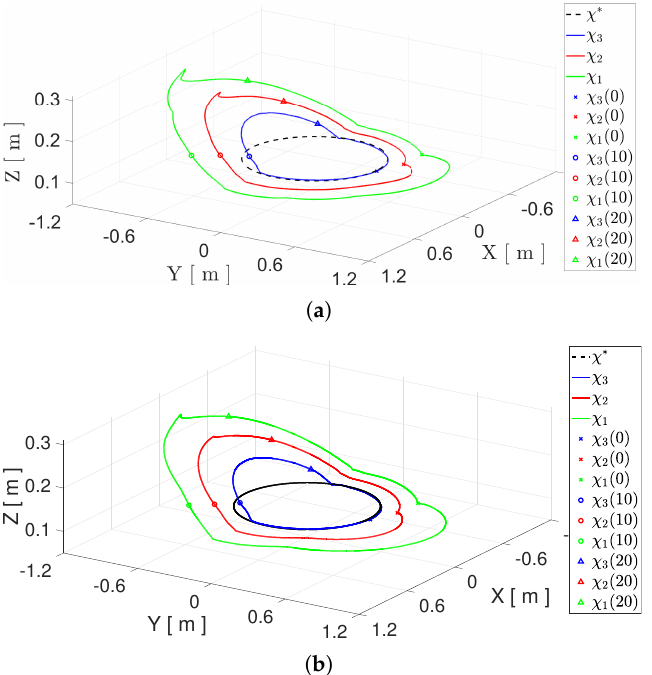
Figure 10. Trajectory in the three dimensional space of the mobile robots for the second experiment. ( a ) Trajectory in the three dimensional space with the GPIO approach. ( b ) Trajectory in the three dimensional space with the PI approach.